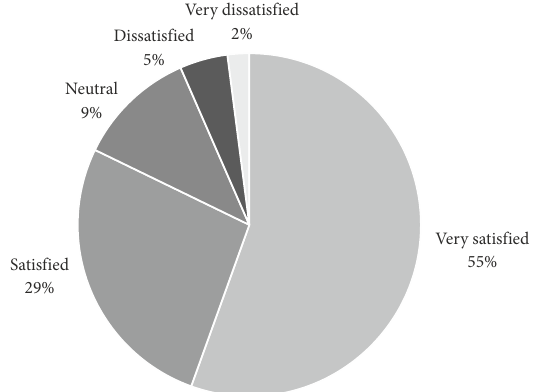
Table 10. CRS comparison between forms